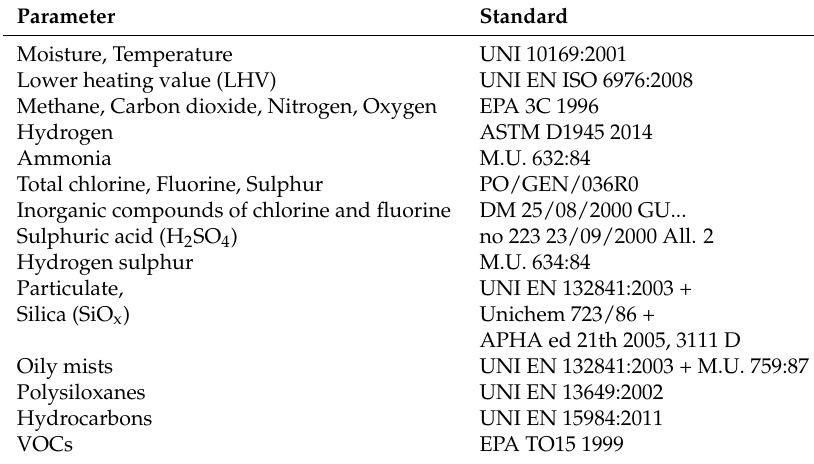
Table 6. Standards used to measure biogas